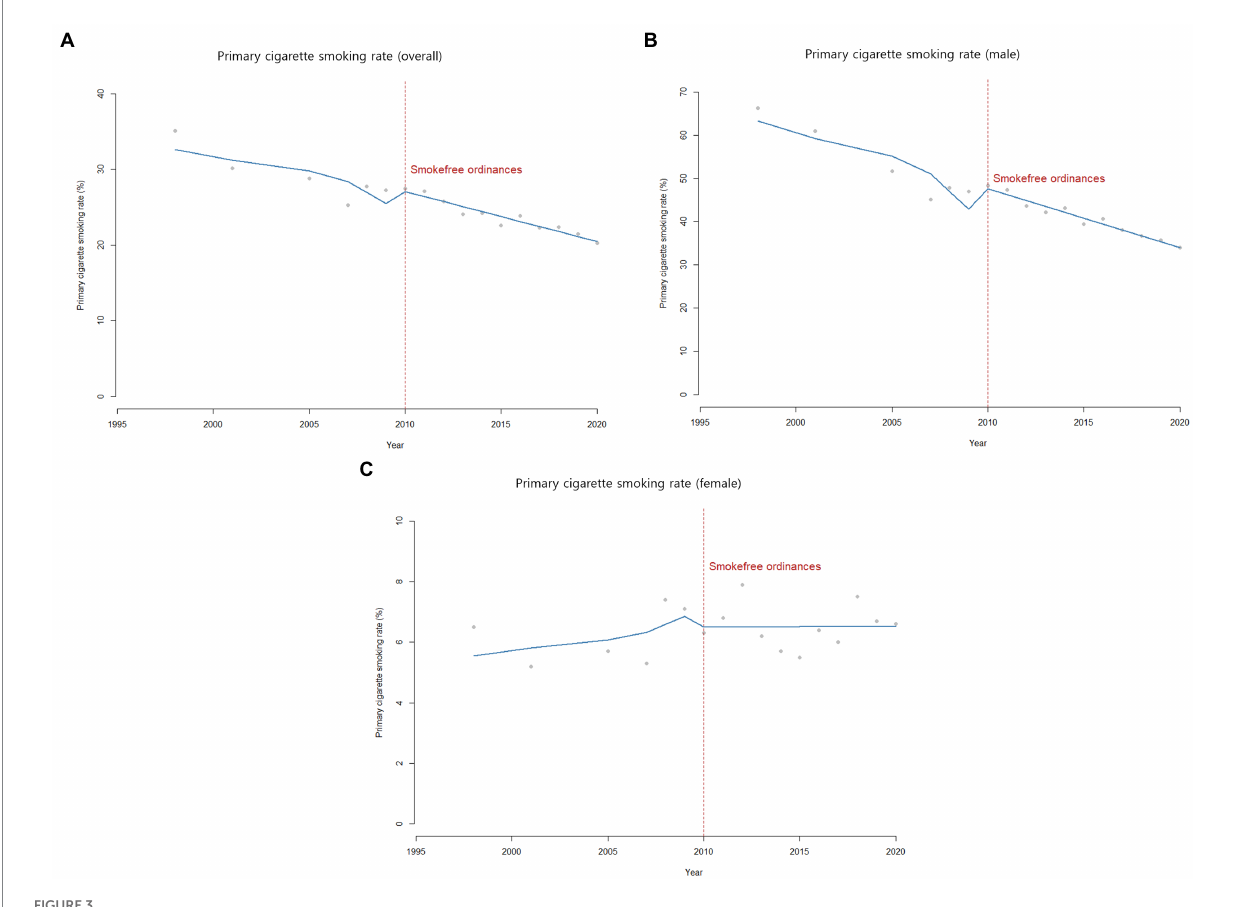
FIGURE 3 Primary cigarette smoking rate among adults in ROK